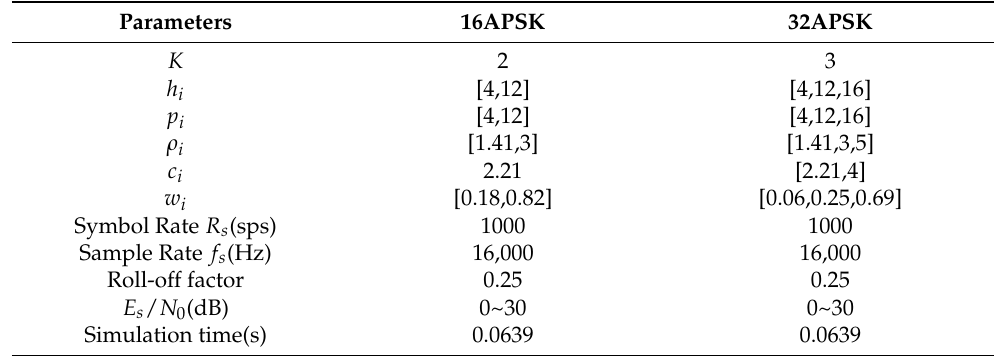
Table 1. The coding principle and dictionary update of the CS-based LZW